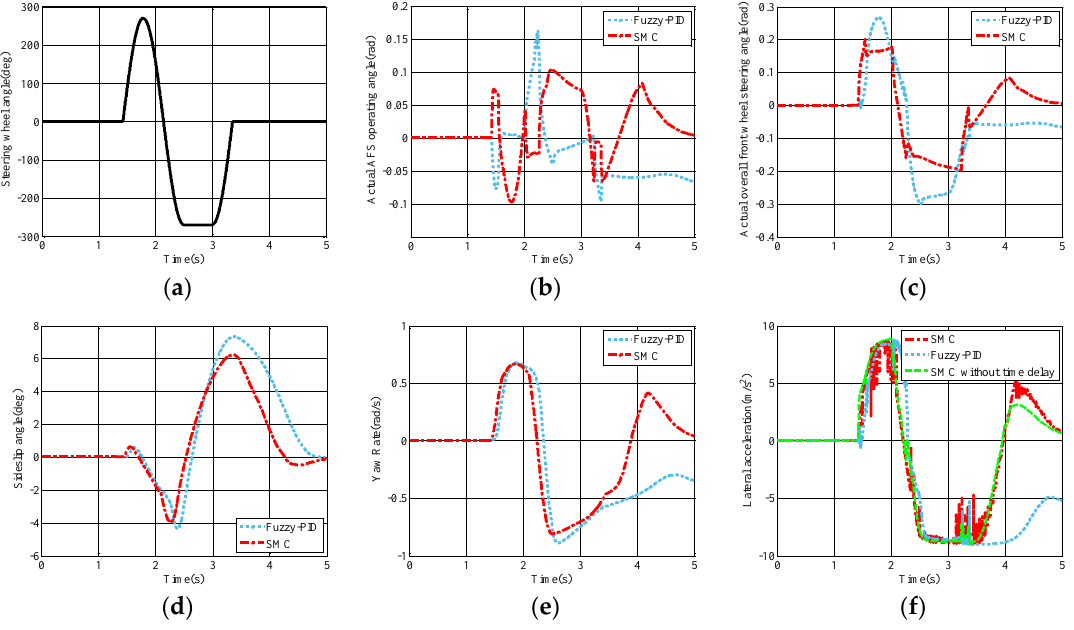
Figure 10. Simulation results of the Sine with Dwell test: ( a ) steering wheel angle; ( b ) actual AFS operating angle; ( c ) actual overall front wheel steering angle; ( d ) sideslip angle; ( e ) yaw rate; and ( f ) lateral acceleration. Table 3. Improvements in peak values and RMS values.